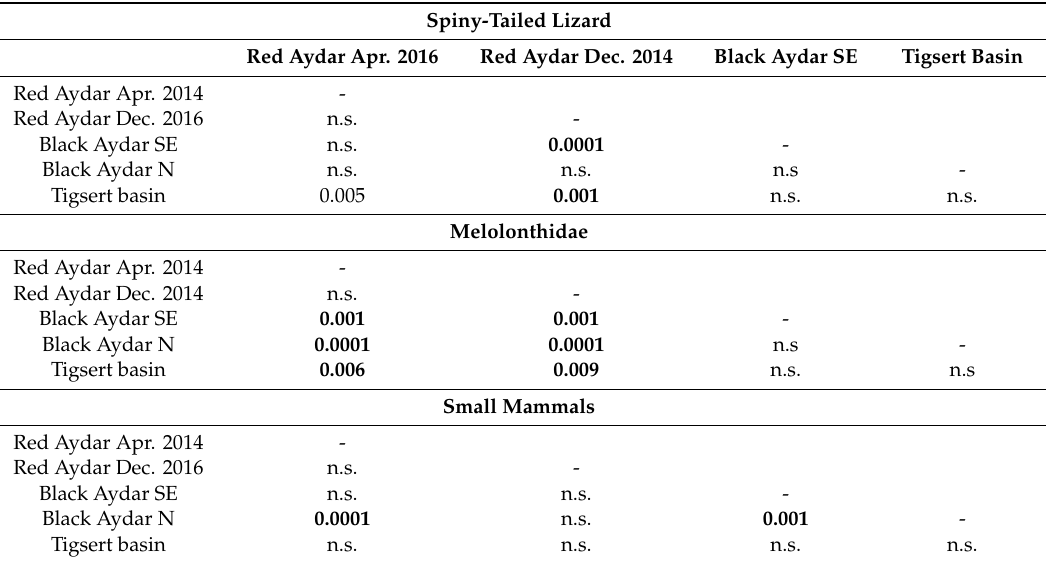
Figure 3. Diet of the honey badger in the Atlantic Sahara expressed as a percentage of volume in the scats. In ( ) number of feces. Table 2. Results of Mann-Whitney’s pairwise tests ( P values corrected by the Holm-Bonferroni adjustment) between areas/seasons.